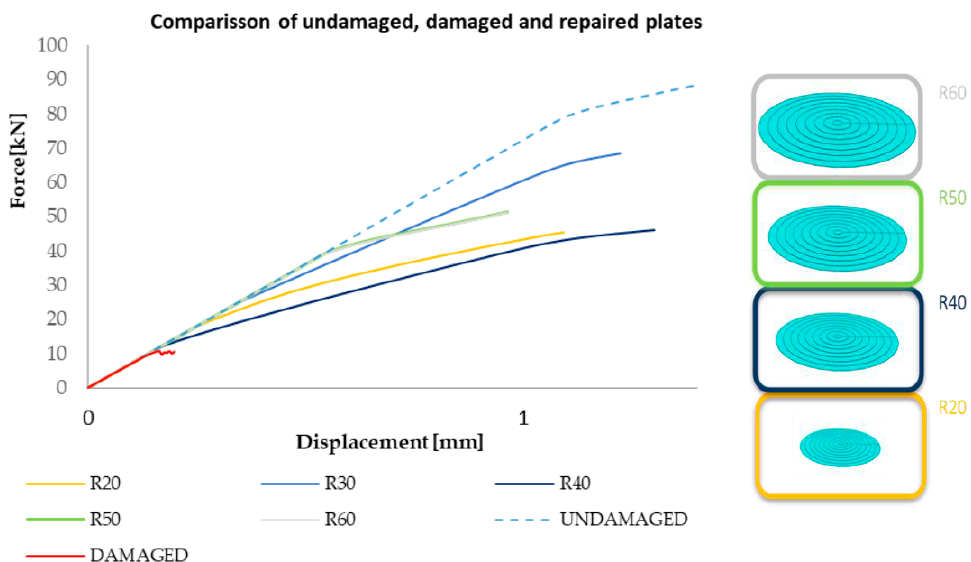
Figure 4. Numerically predicted force-displacement curves of undamaged, damaged and repaired laminates.